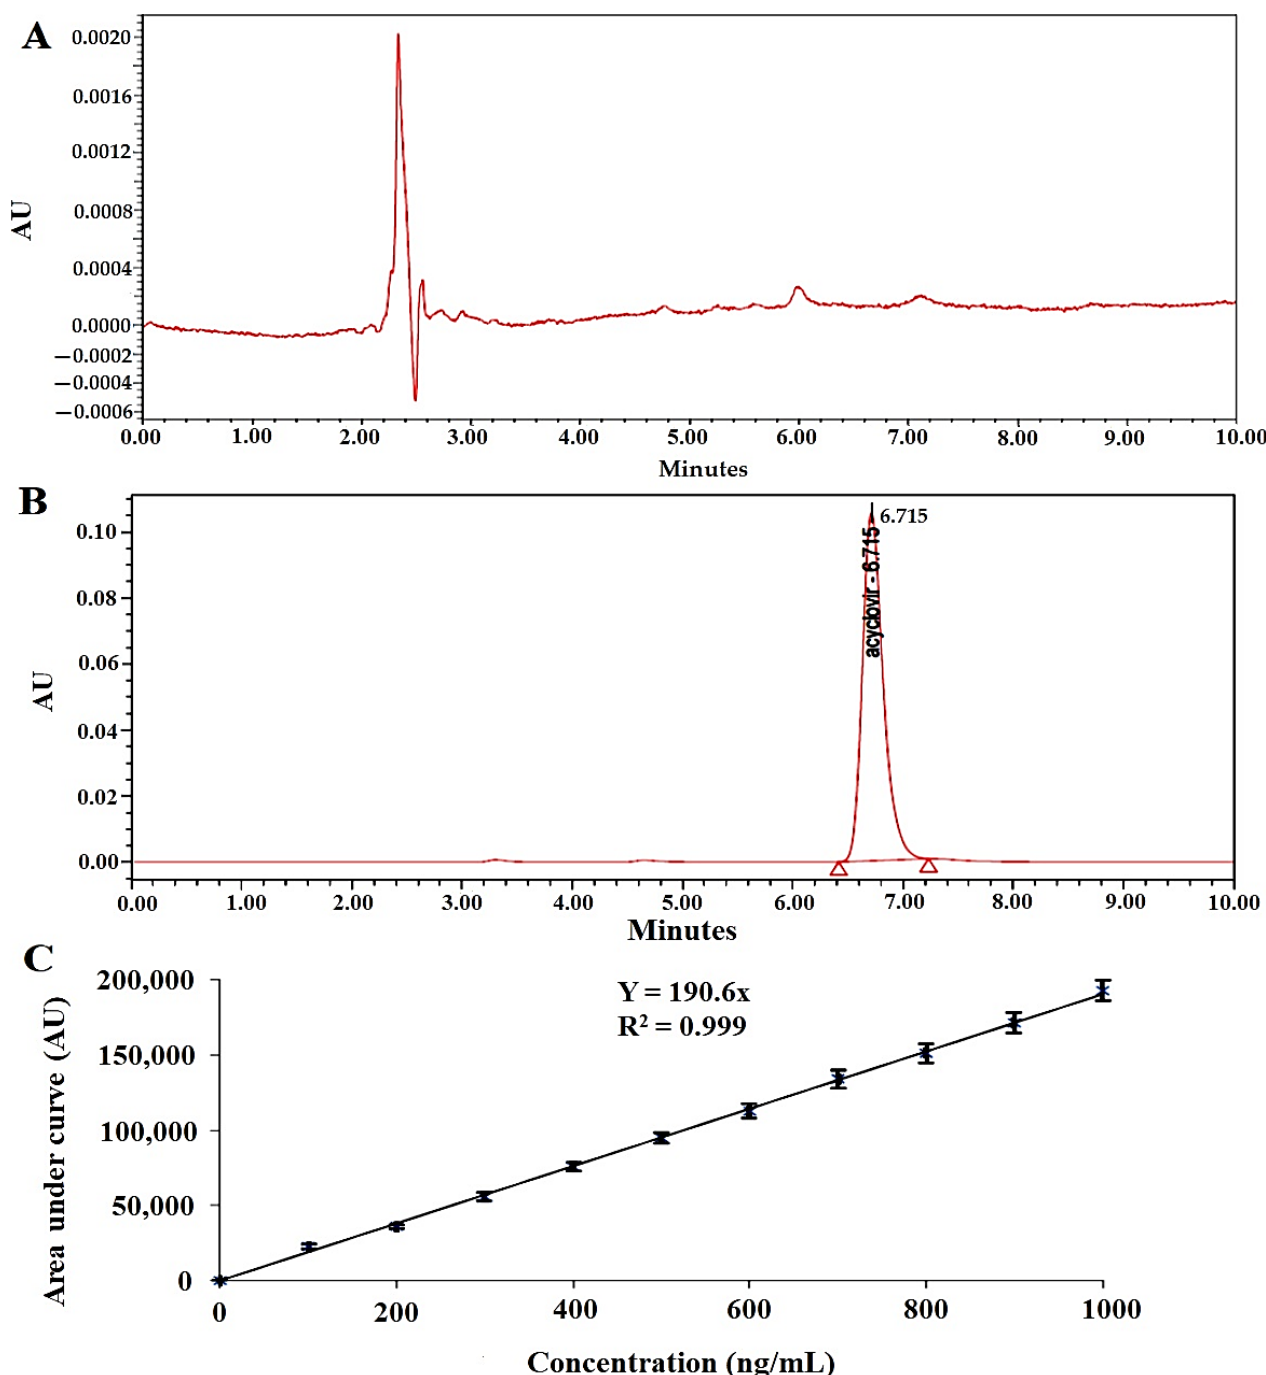
Figure 4. ( A ) Blank plasma, ( B ) chromatogram of ACV in plasma, and ( C ) calibration plot of ACV in plasma. Table 6. % Recovery data of optimized bioanalytical method of ACV.